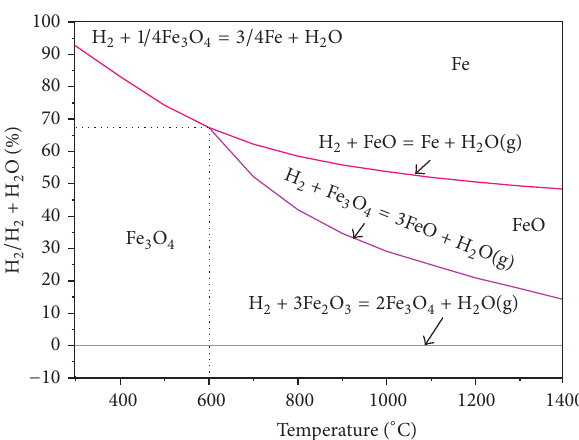
Figure 5: Gas-phase equilibrium composition of H 2 -reduced iron oxide.